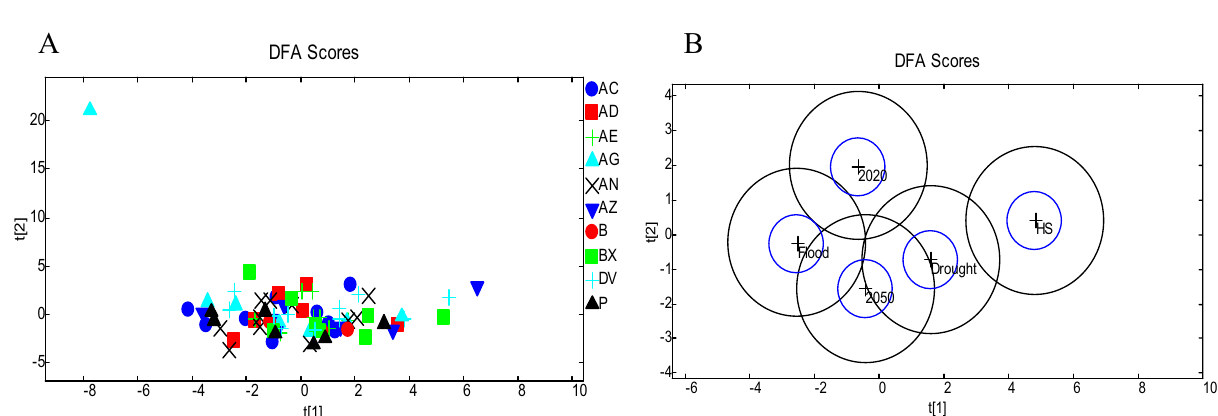
Figure 1. DFA analysis of grass variety based on FTIR analysis, showing no distinct clustering between varieties ( AC Aber Clyde, AD Aber Dart, AE Aber Echo, AG Aber Glyn, AN Aber Niche, AZ Aber Zeus, B Barolex, BX Aber Root, DV Da vinci, P Premium ( A ); climate scenarios ( B ), showing distinct clustering between environmental conditions (DFA circles around the mean group centres with 95% confidence circles for DF1 vs DF2; HS heat